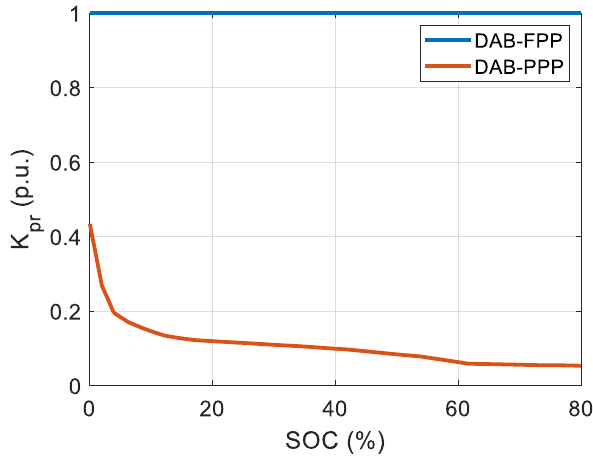
Figure 7. Processed power ratio comparison between the DAB-FPP and the DAB-PPP.